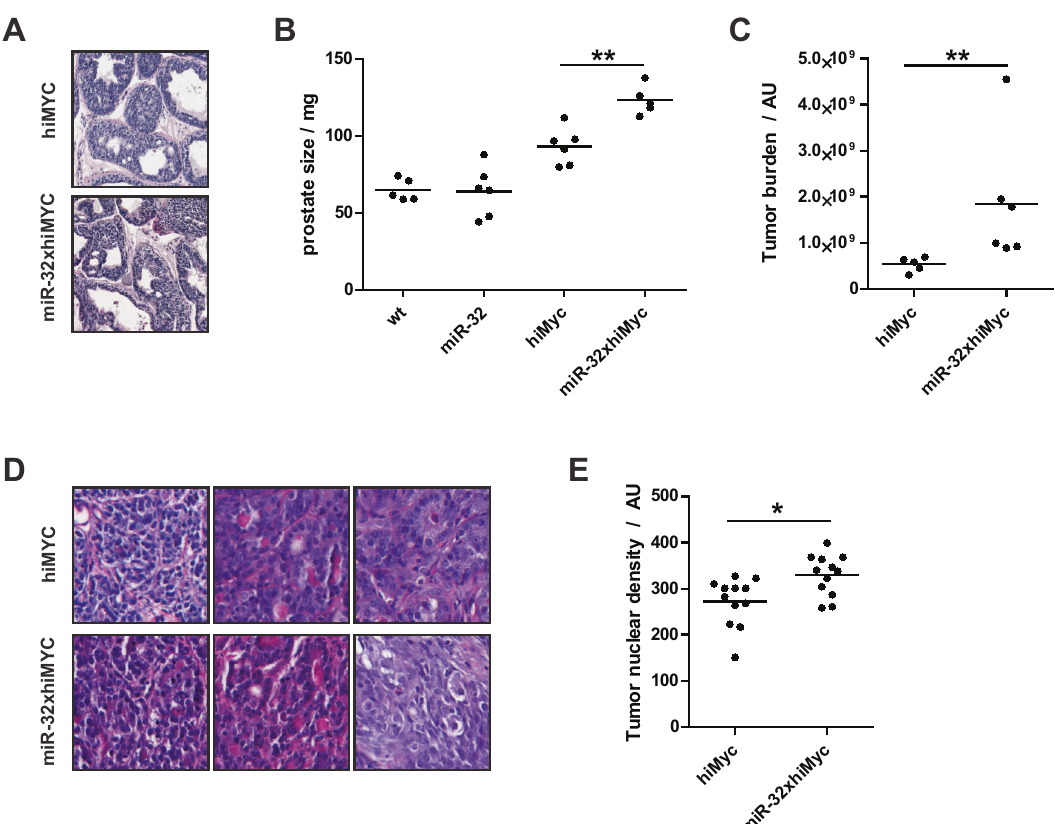
Fig. 1 Transgenic miR-32 promotes tumor development in hiMYC model of prostate adenocarcinoma. A Histology of prostate shows intraepithelial neoplasia at 1 month of age in both hiMYC and miR-32xhiMYC mice. Examples from HE-stained lateral lobe. B Prostate size at 6 months of age in wt, miR-32 transgenic, hiMYC, and miR-32xhiMYC mice. C Tumor burden quanti fi ed as a sum of tumor areas on whole slide images of tissue sections taken every 50 µm apart throughout the organ in prostates of hiMYC and miR-32xhiMYC mice at 6 months of age. D Example histology of tumors in 6-month-old hiMYC and miR-32xhiMYC mouse prostates. E Tumor nuclear density in most advanced tumors in 6-month-old hiMYC and miR-32xhiMYC mouse prostates. p values *<0.05,